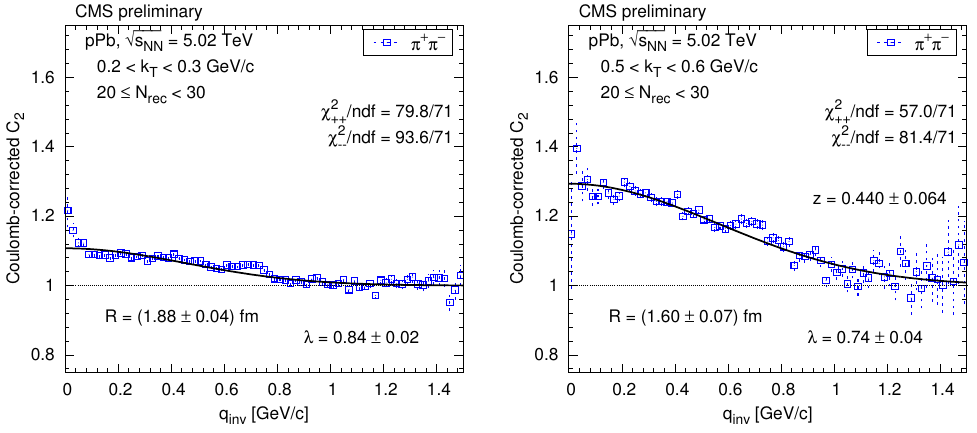
Figure 2. Contribution of clusters (mini-jets and multi-body decays of resonances) to the measured Coulomb-corrected correlation function of π + π − (open squares) for some selected k T bins, 20 ≤ N rec < 30, in case of pPb interactions at result of the Gaussian